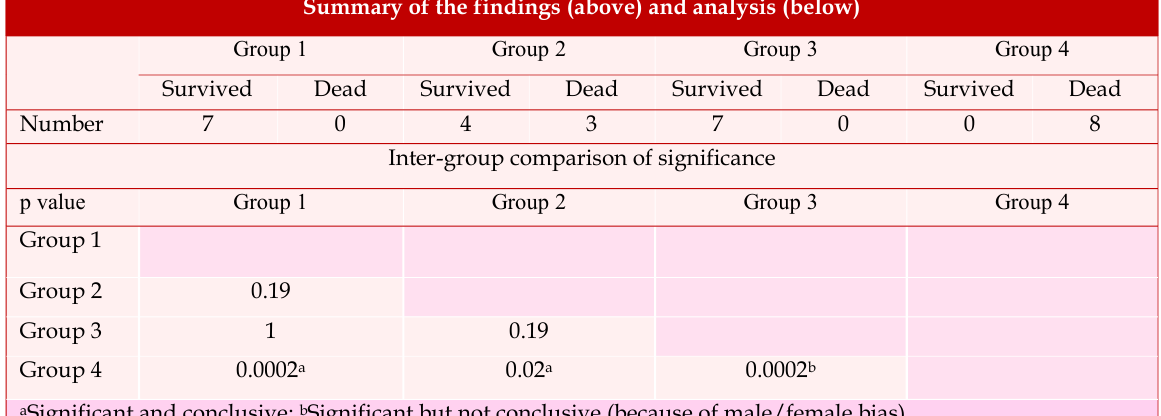
Summary of the findings (above) and analysis